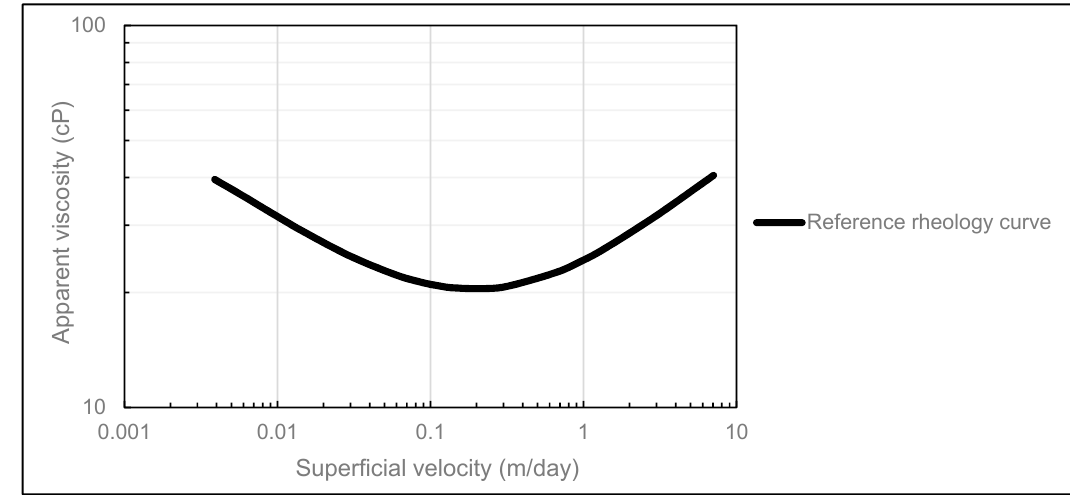
Figure 2. Reference (base case) rheology curve used for pressure measurement error analysis.